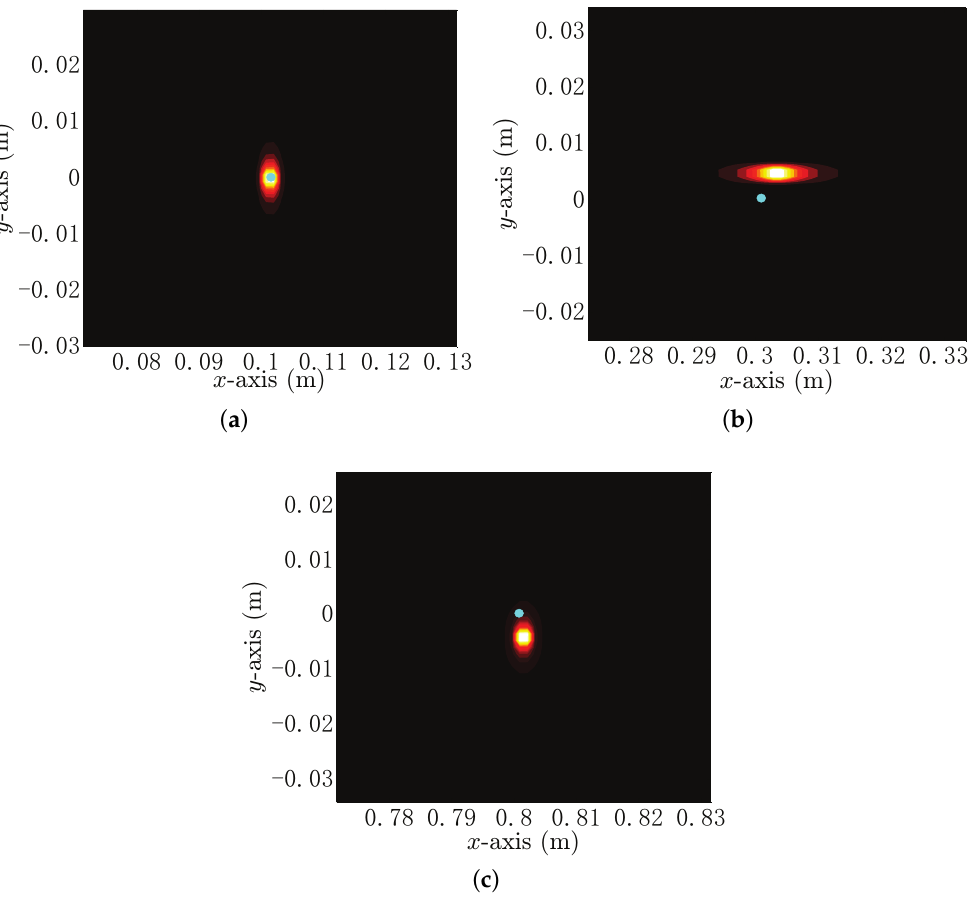
Figure 4. The ratio of the magnitude of the primary energy and the secondary energy E sec target is in a different position.